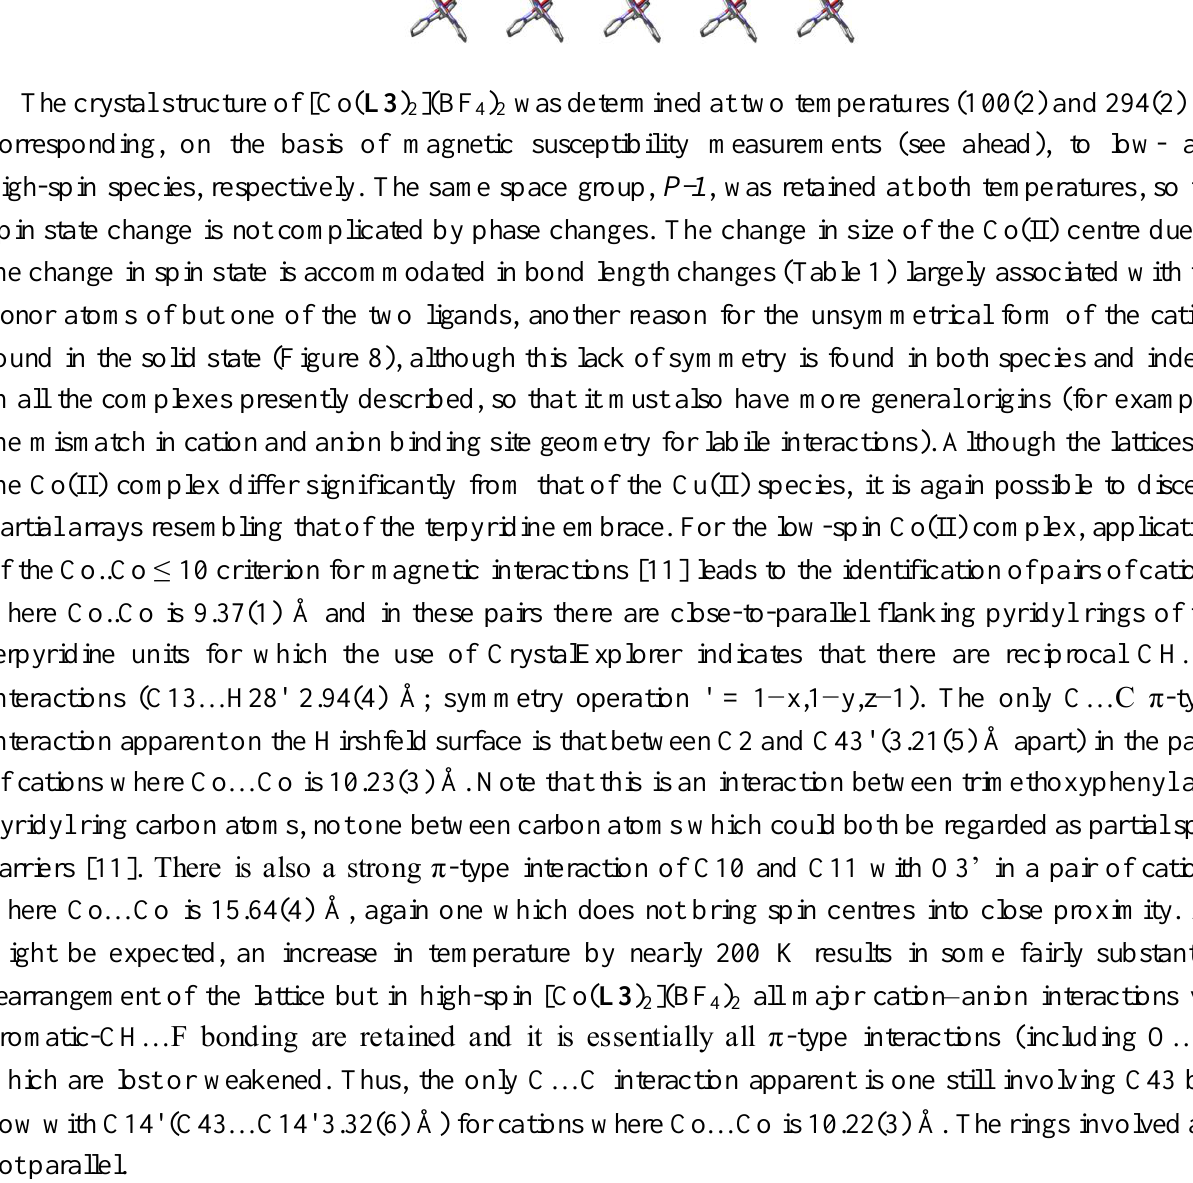
](ClO ) ∙CH CN 2 4 2 3